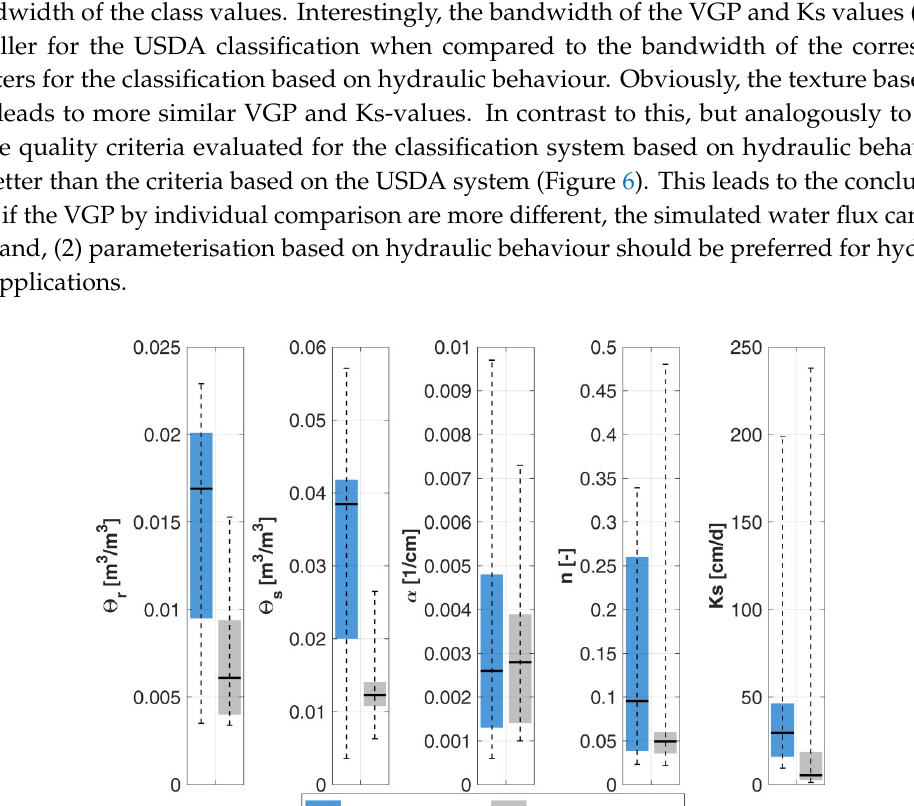
Figure 5. Standard deviation of van Genuchten Parameters and Ks values within the classes (blue = evaluation based on hydraulic response classes; grey = based on USDA classes). The horizontal black lines show the median. The boxes show the 25% and 75% percentiles and the whiskers symbolise the minima and maxima.